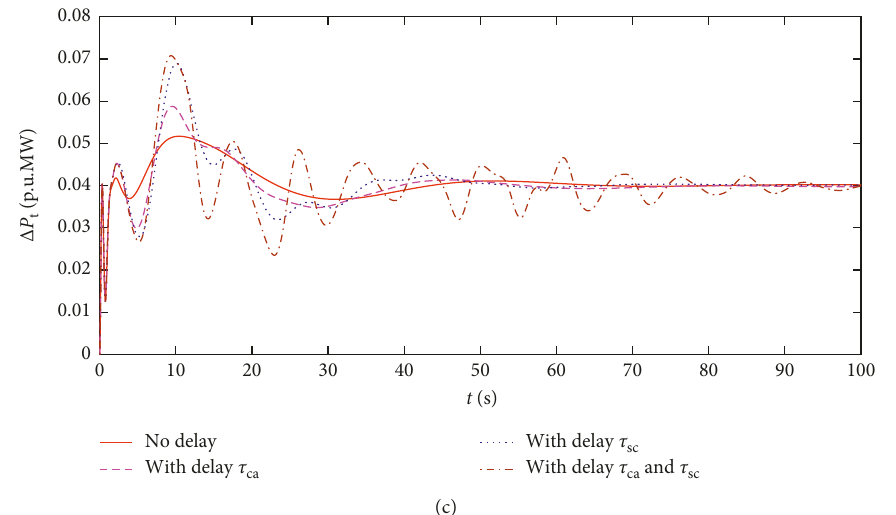
Figure 3: Output response curves under four kinds of delays. (a) ACE response curve. (b) Δ f response curve. (c) Δ P